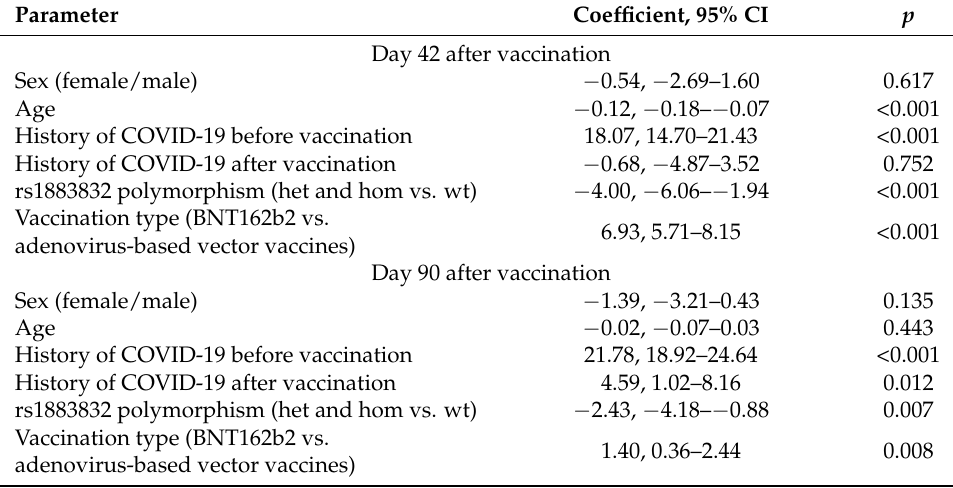
Table 3. Multivariable analysis exploring the risk factors affecting the anti-SARS-CoV-2 IgA levels at days 42 and 90 after